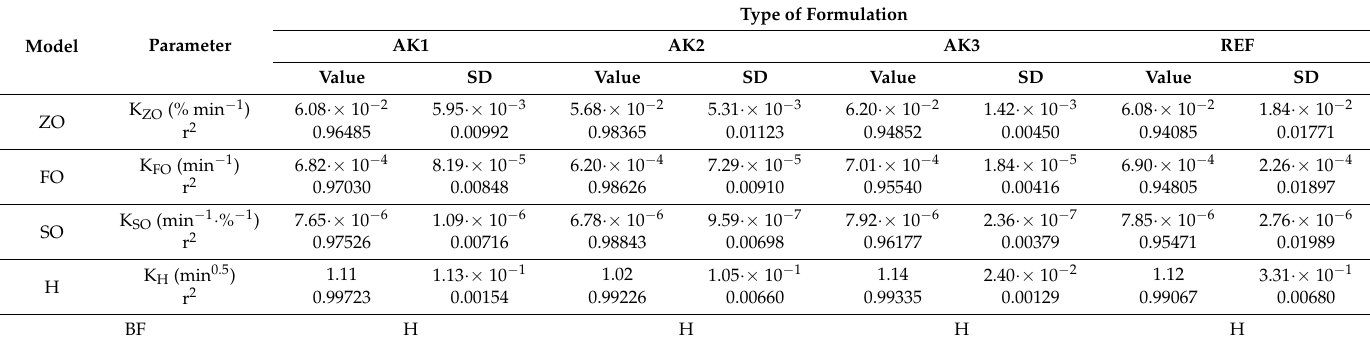
Table 3. The release rates K ZO , K FO , K SO , K H , and determination coefficients (R 2 ), respectively, for the evaluated kinetics models: ZO—zero-order process, FO—first-order process, SO—second-order process, and H—Higuchi model for the release of naproxen sodium (NS) from formulations AK1–AK3 and REF, at temperature of 22 ◦ C.